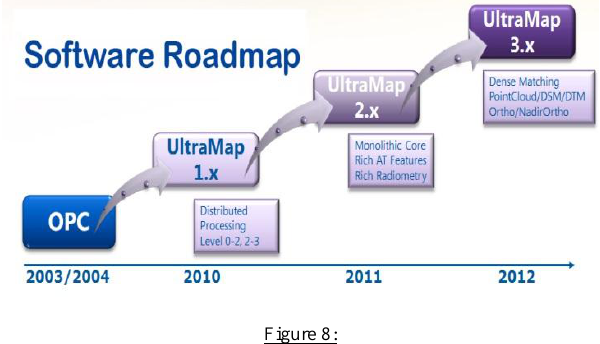
Figure 8: The original ground based post-processing software was denoted as “OPC” [Office Processing Center]. With the advent of Microsoft’s Seadragon capability, this morphed into the UltraMap system. The augmentation by a dense matching product is on its